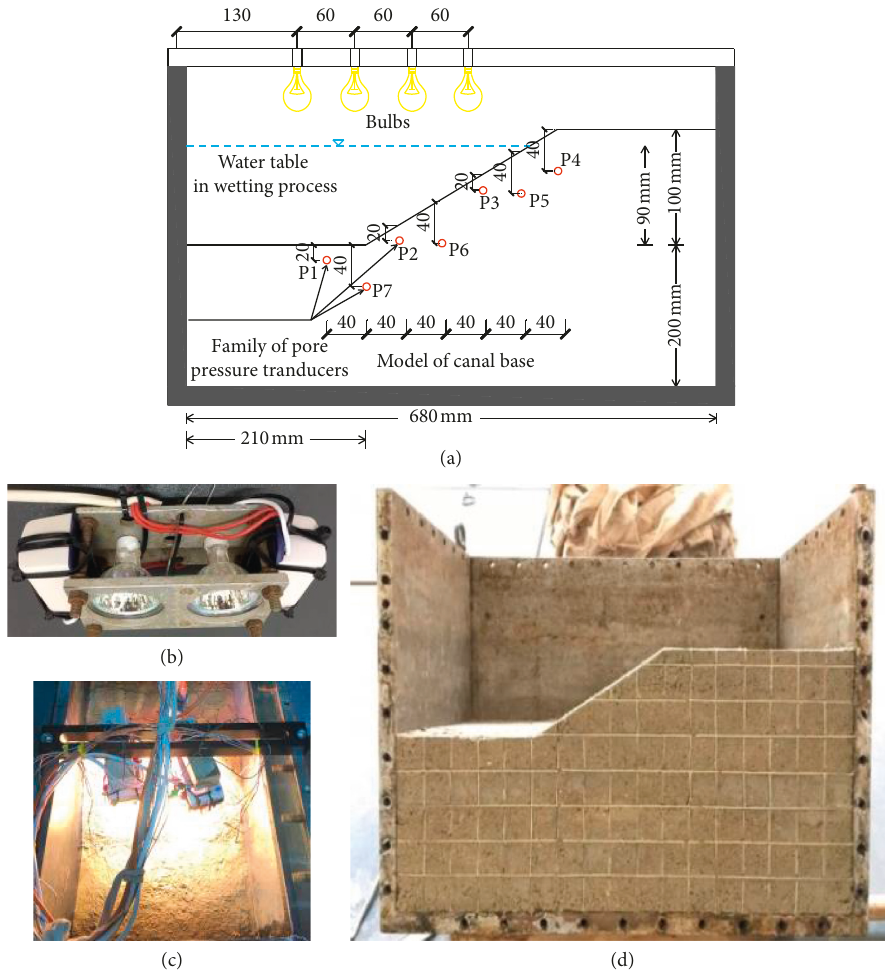
Figure 6: Centrifuge modeling of canal slope using bulbs (not to scale).